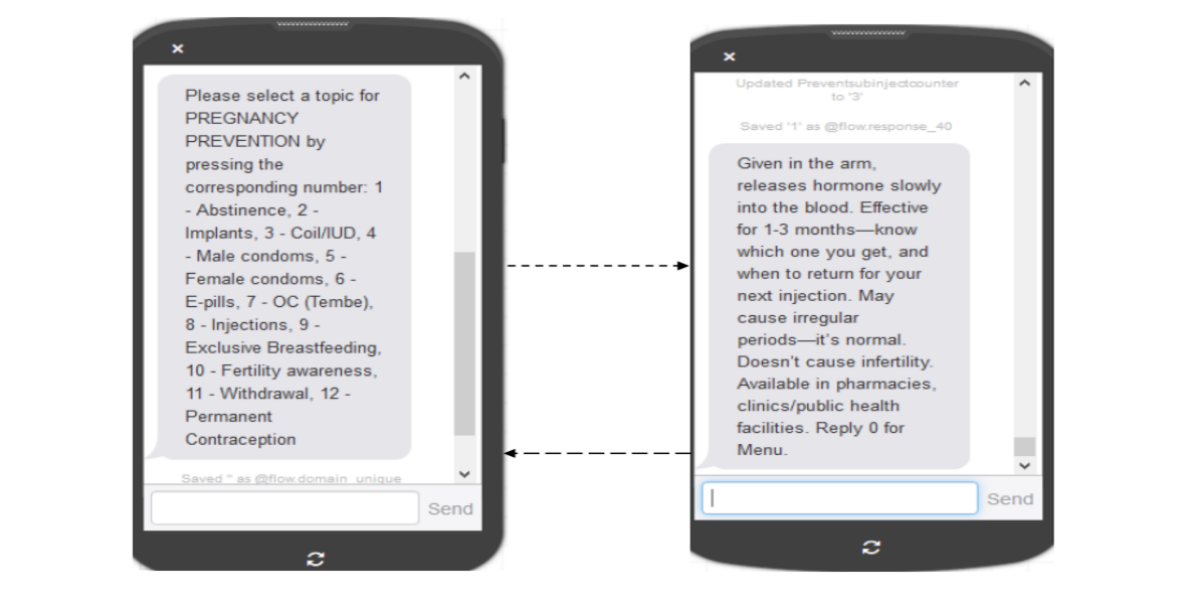
Figure 3. Example Adolescent/Youth Reproductive Mobile Access and Delivery Initiatives for Love and Life Outcome subdomain menu with sample ‘injection (#8) message requested’(English